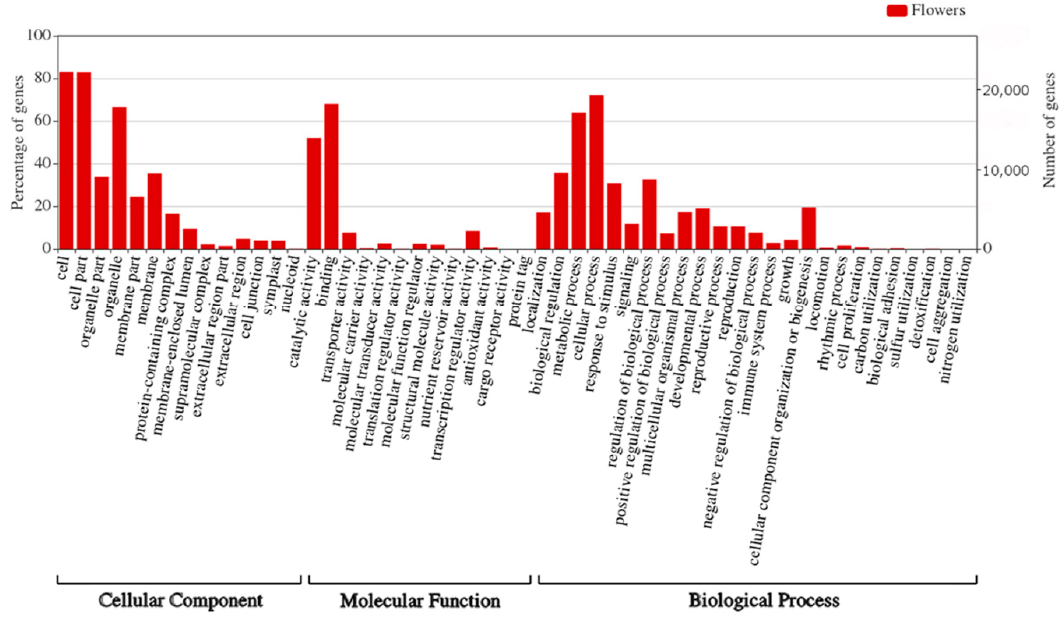
Figure 9. Visualization of GO categories annotated to predicted target genes of known and novel miRNAs in yellow lupine.